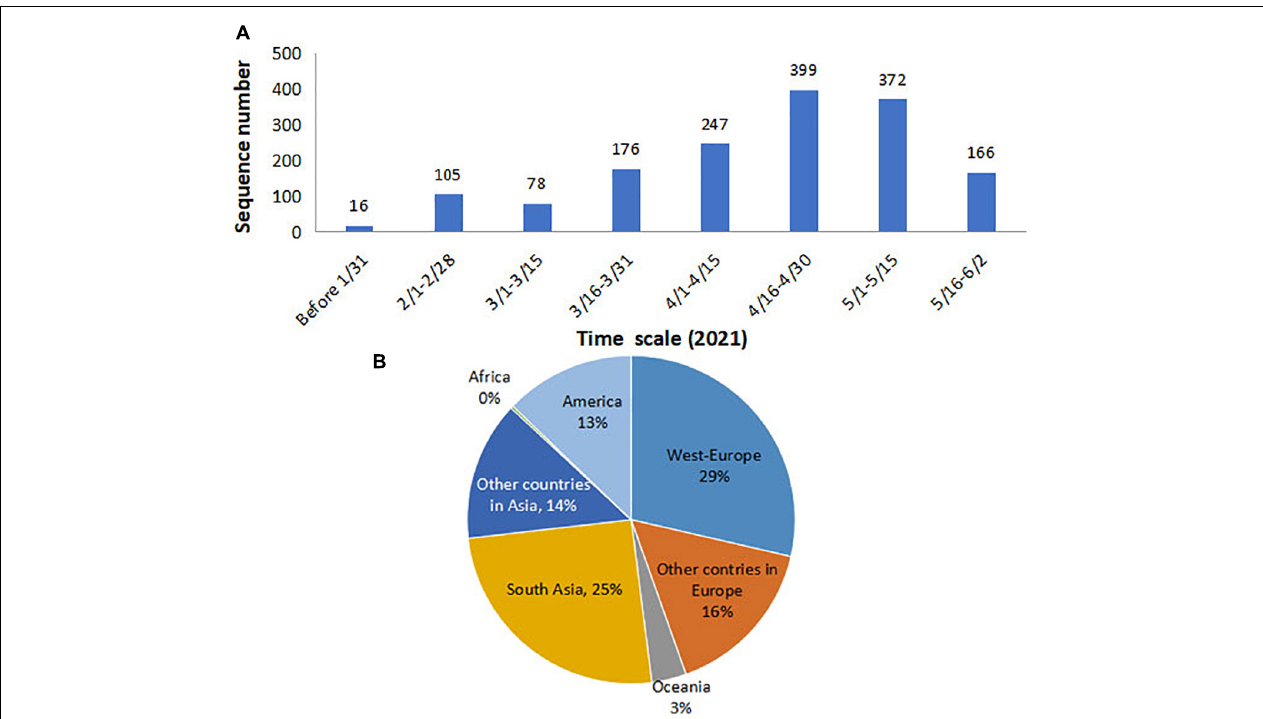
FIGURE 1 | Time and location distributions of the SARS-CoV-2 B.1.617 sequences collected for the purpose of this study. (A) Monthly distribution: the number of sequences increased sharply since March 2021. (B) Geographical distribution: 29 and 25% of sequences were from Western Europe and Southern Asia, respectively. SARS-CoV-2, severe acute respiratory syndrome coronavirus